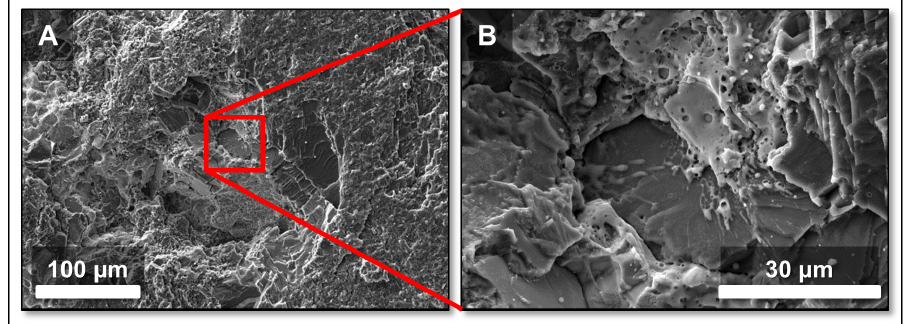
Figure 23. Scanning electron microscope images of an LIBS ablation crater in calcite (darker gray) and a Cu-sulfide (brighter gray). The ablation craters generally show brittle behavior ( A ); however, up close, both calcite and copper sulfide also display melting behavior ( B